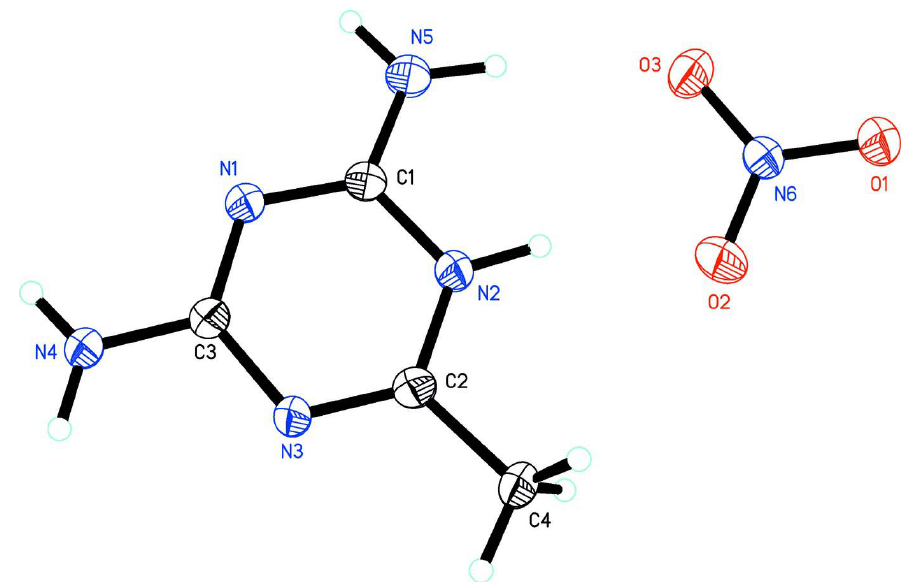
Figure 1 The molecular structure of the title compound with the atom-numbering scheme. Displacement ellipsoids are drawn at the 30% probability level.